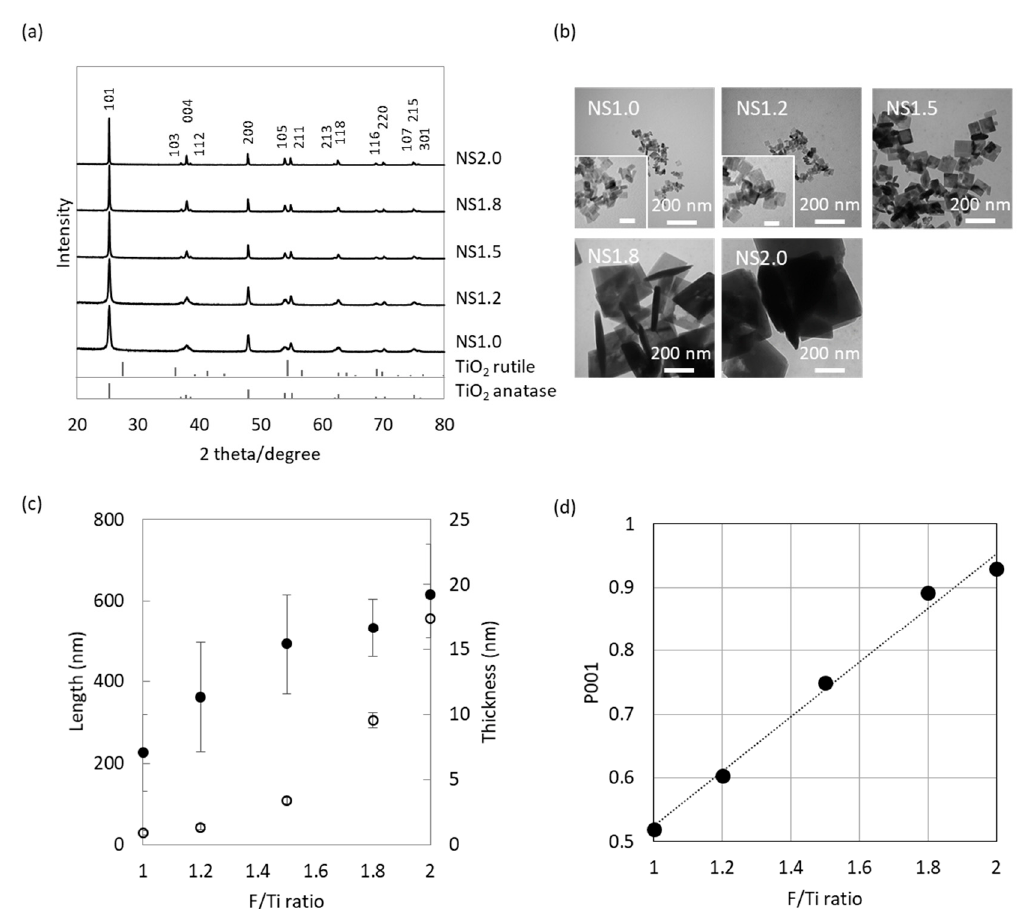
Figure 1. Characterization of TiO 2 (titania) nanosheet. ( a ) XRD patterns of TiO 2 NS1.0, 1.2, 1.5, 1.8, 2.0, and nanoparticle (NP). ( b ) TEM images of TiO 2 NS (nanosheet). The inset is a high magnification of samples. Scale bar: 50 µ m ( c ) Length and thickness of each nanosheet measured from TEM images. Open circle: thickness (nm), Closed circle: Length (nm). ( d ) The ratio of {001} facet (P 001 ) calculated from length and thickness.